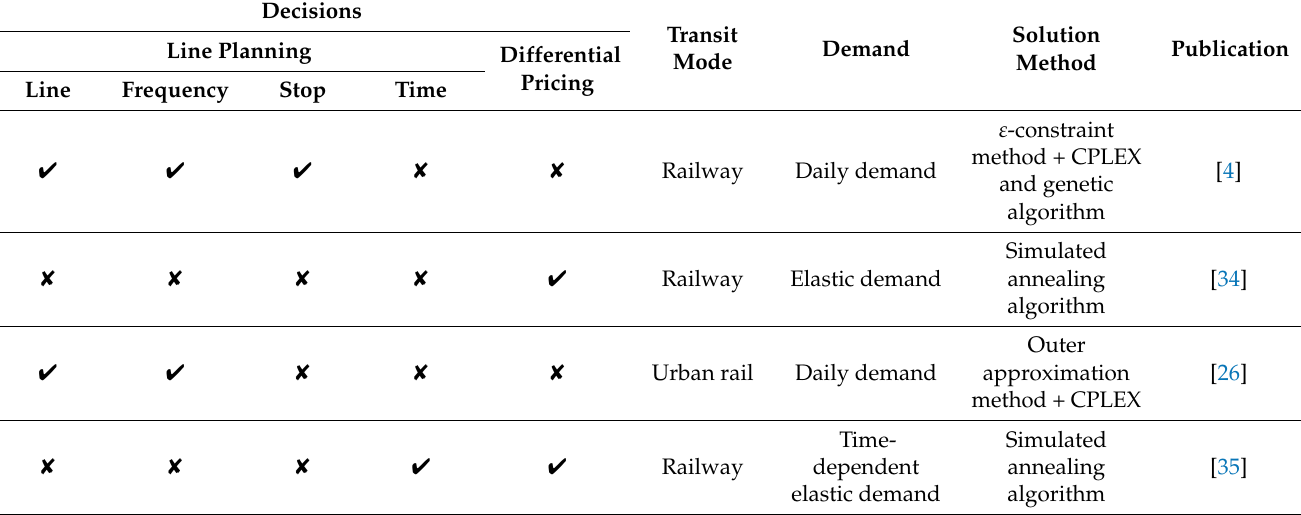
Table 1. Comparison of relevant literature of different